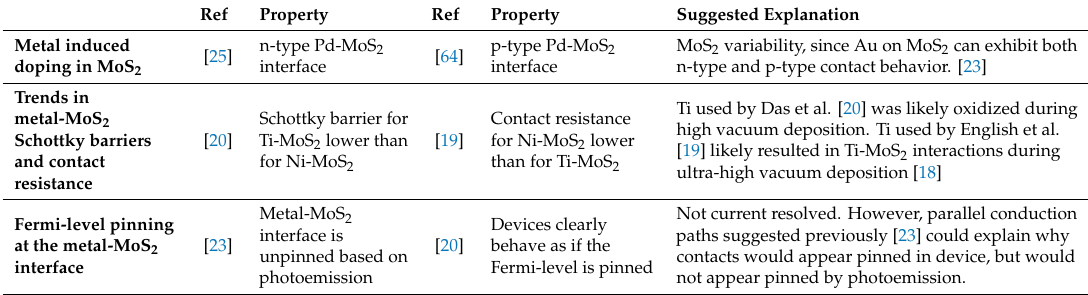
Table 2. Summary of property variability reported and possible